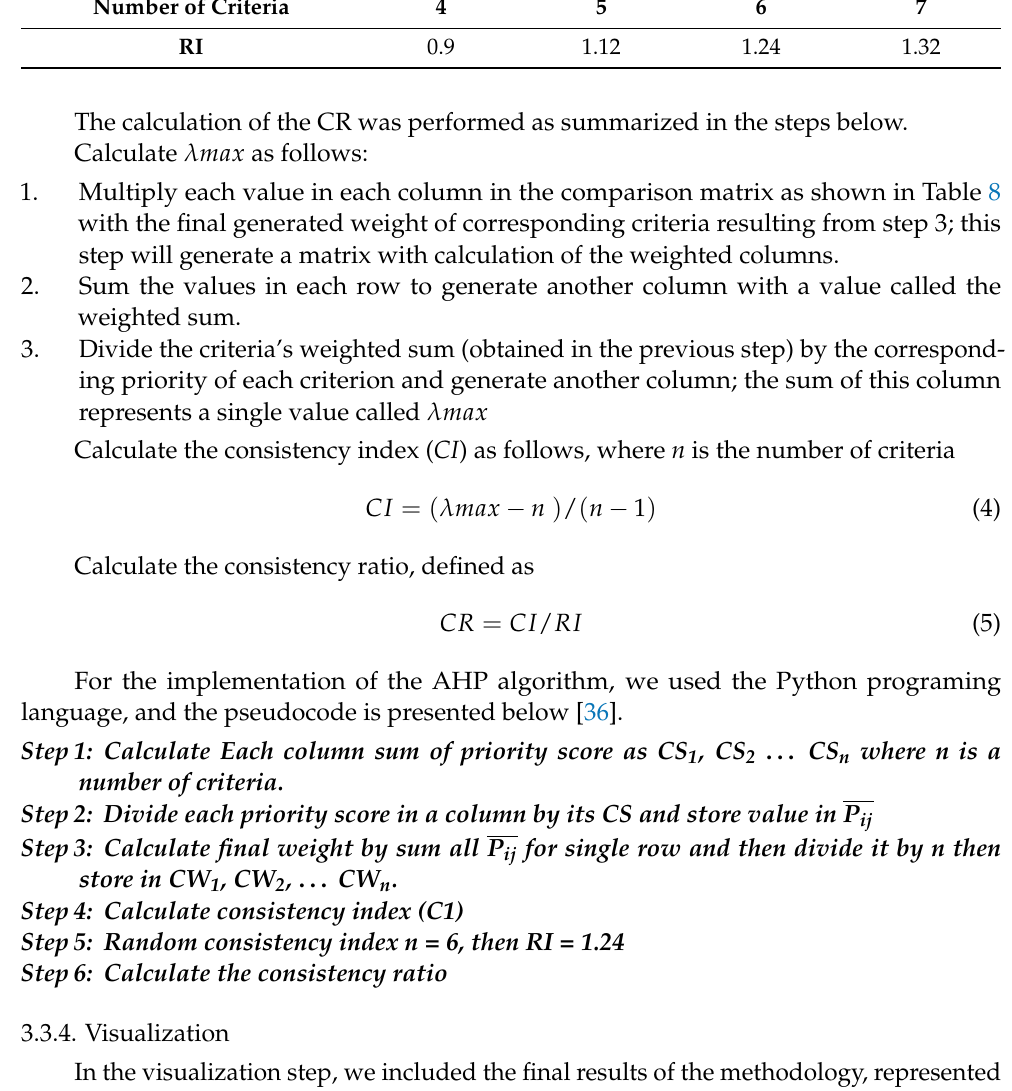
Table 9. Consistency indices for a randomly generated matrix. Number of